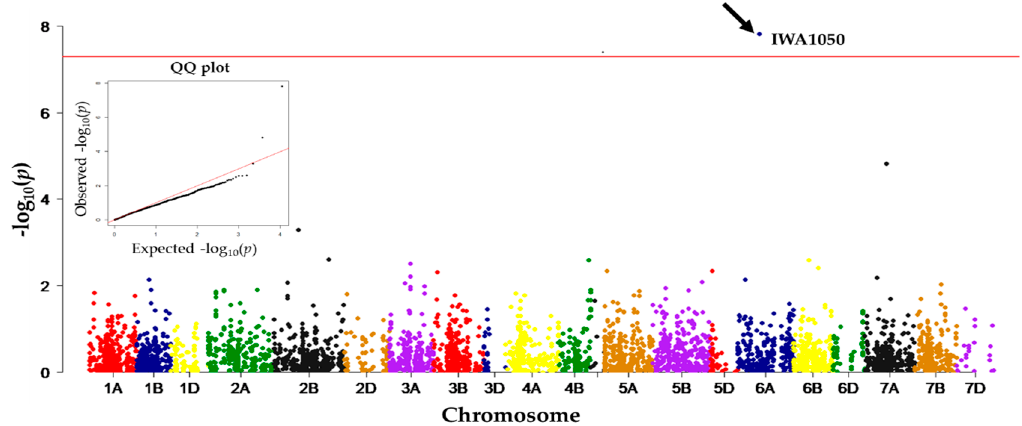
Figure 5. Manhattan plot, and QQ (quantile-quantile) plot, from genome-wide association studies for freezing tolerance (measured as electrolyte leakage) in 192 winter wheat landraces using 5476 SNPs. Deflation of the QQ plot was due to the use of genetic loci associated with population structure and latitude as covariates.